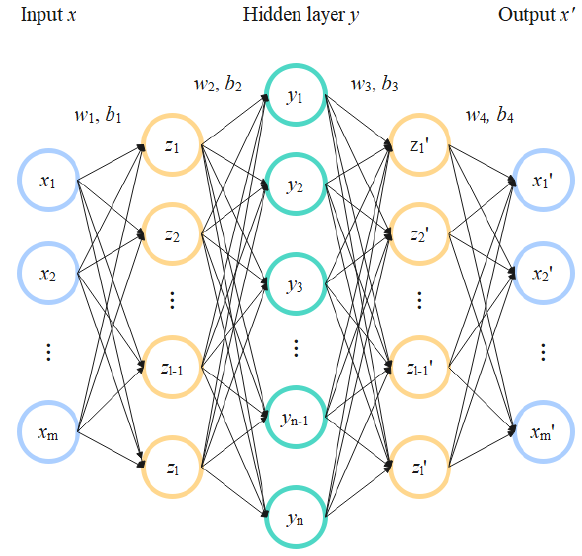
Figure 1. The structure of the autoencoder used in this work.